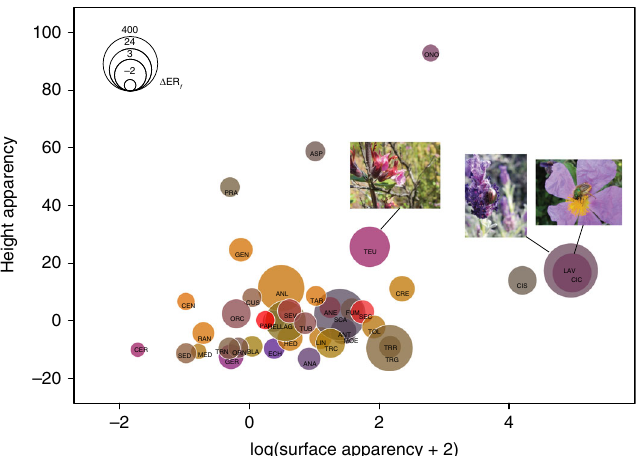
Fig. 4 Floral apparency in the study community. Apparency values have been calculated by taking into consideration only the co- fl owering species (see Methods). Disc radii are scaled versions of the apparency of the total volatile emissions ( Δ ER f ). Disc colours approximate the human-perceived colours of the fl owers in the RGB system. Flowers of Teucrium divaricatum (TEU), Lavandula stoechas subsp. stoechas (LAV) and Cistus creticus (CIC) that exhibit high terpenoid emissions are shown. For the co- fl owering species and for the abbreviations of scienti fi c names, see Supplementary Table 6. Photos by A.